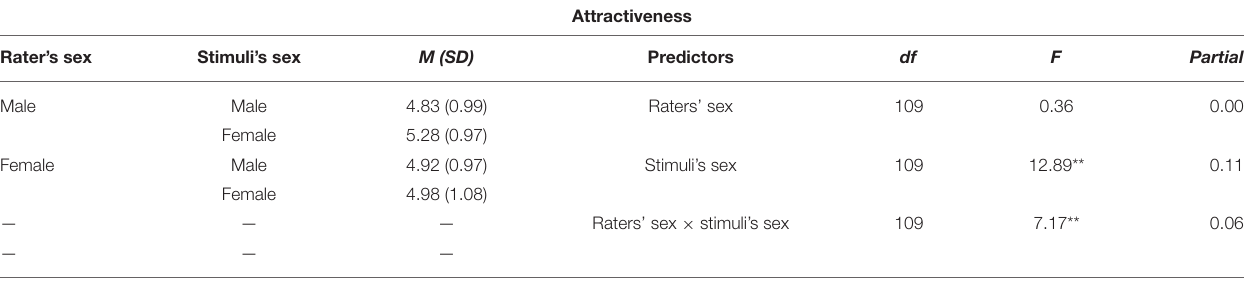
TABLE 2 | Mean, SD, and MANOVA of raters’ sex and multimodal stimuli’s sex in Study 2.